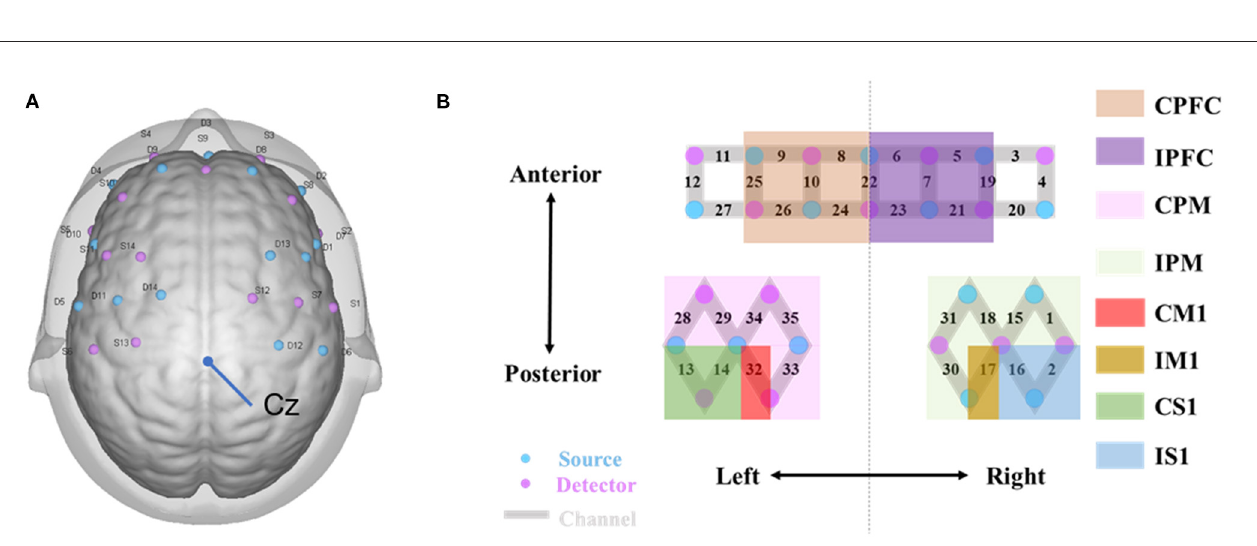
FIGURE3 fNIRS data acquisition. (A) fNIRS optode layout design. Blue and purple-filled circles represent light sources and detectors, respectively. Gray rectangles represent long separation channels. The midline central point (Cz) is located at the middle point of optode S13 and optode D12. (B) Regions of interest and the channel setting. The probes were located over bilateral PFC (CPFC and IPFC); PM (CPM and IPM); bilateral M1 (CM1 and IM1); bilateral S1 (CS1 and IS1). C, contralesional; I, ipsilesional; PFC, prefrontal cortex; PM, premotor area and supplementary motor cortex; M1, primary motor cortex; S1, primary somatosensory cortex.